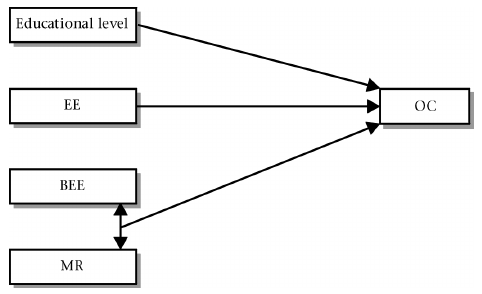
Figure 14: Results of a predictive model for organisation- related commitment